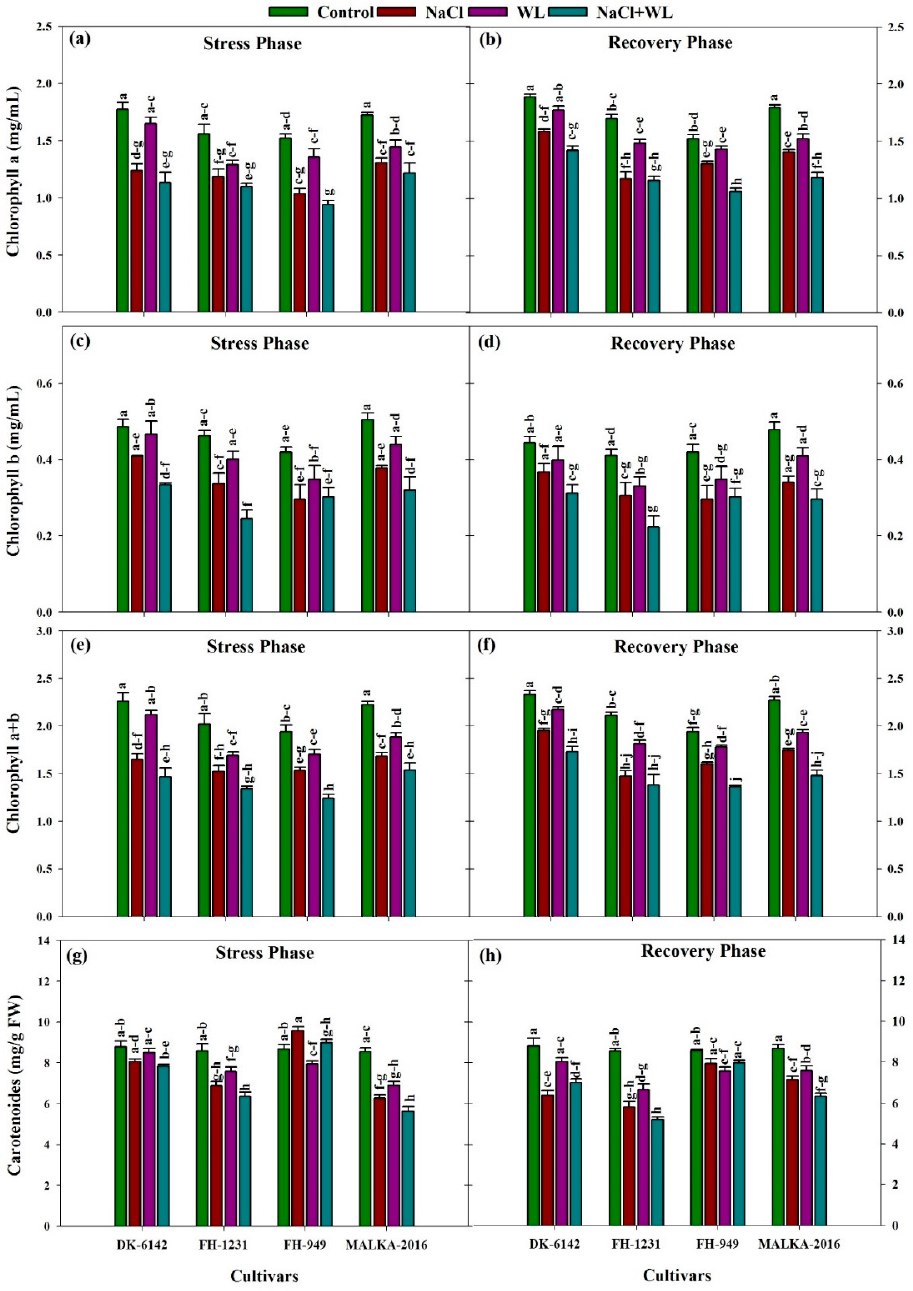
Figure 5. Individual and interactive effects of salinity and waterlogging stress on chlorophyll ‘a’, ‘b’, ‘a + b’ (mg/mL), and carotenoid content of four maize cultivars during the stress (22 DAS) and recovery (30 DAS) phases. Left and right sides of the figure are representing stress phase and recovery phase respectively. Error bars denote the standard error of three replications. Bars with same letter do not differ significantly at p ≤ 0.05.